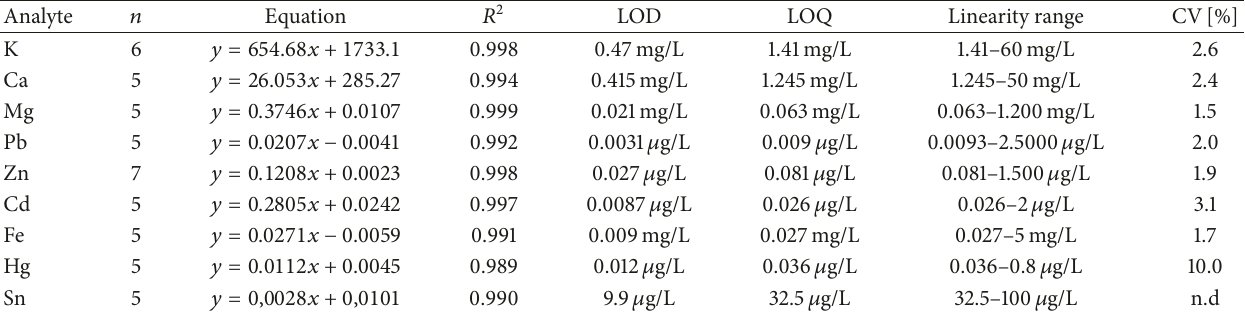
Table 4: Basic validation parameters obtained for each analyte by using developed method ( 𝑛 , number of standards in three replicates; 𝑅 2 , coefficient of